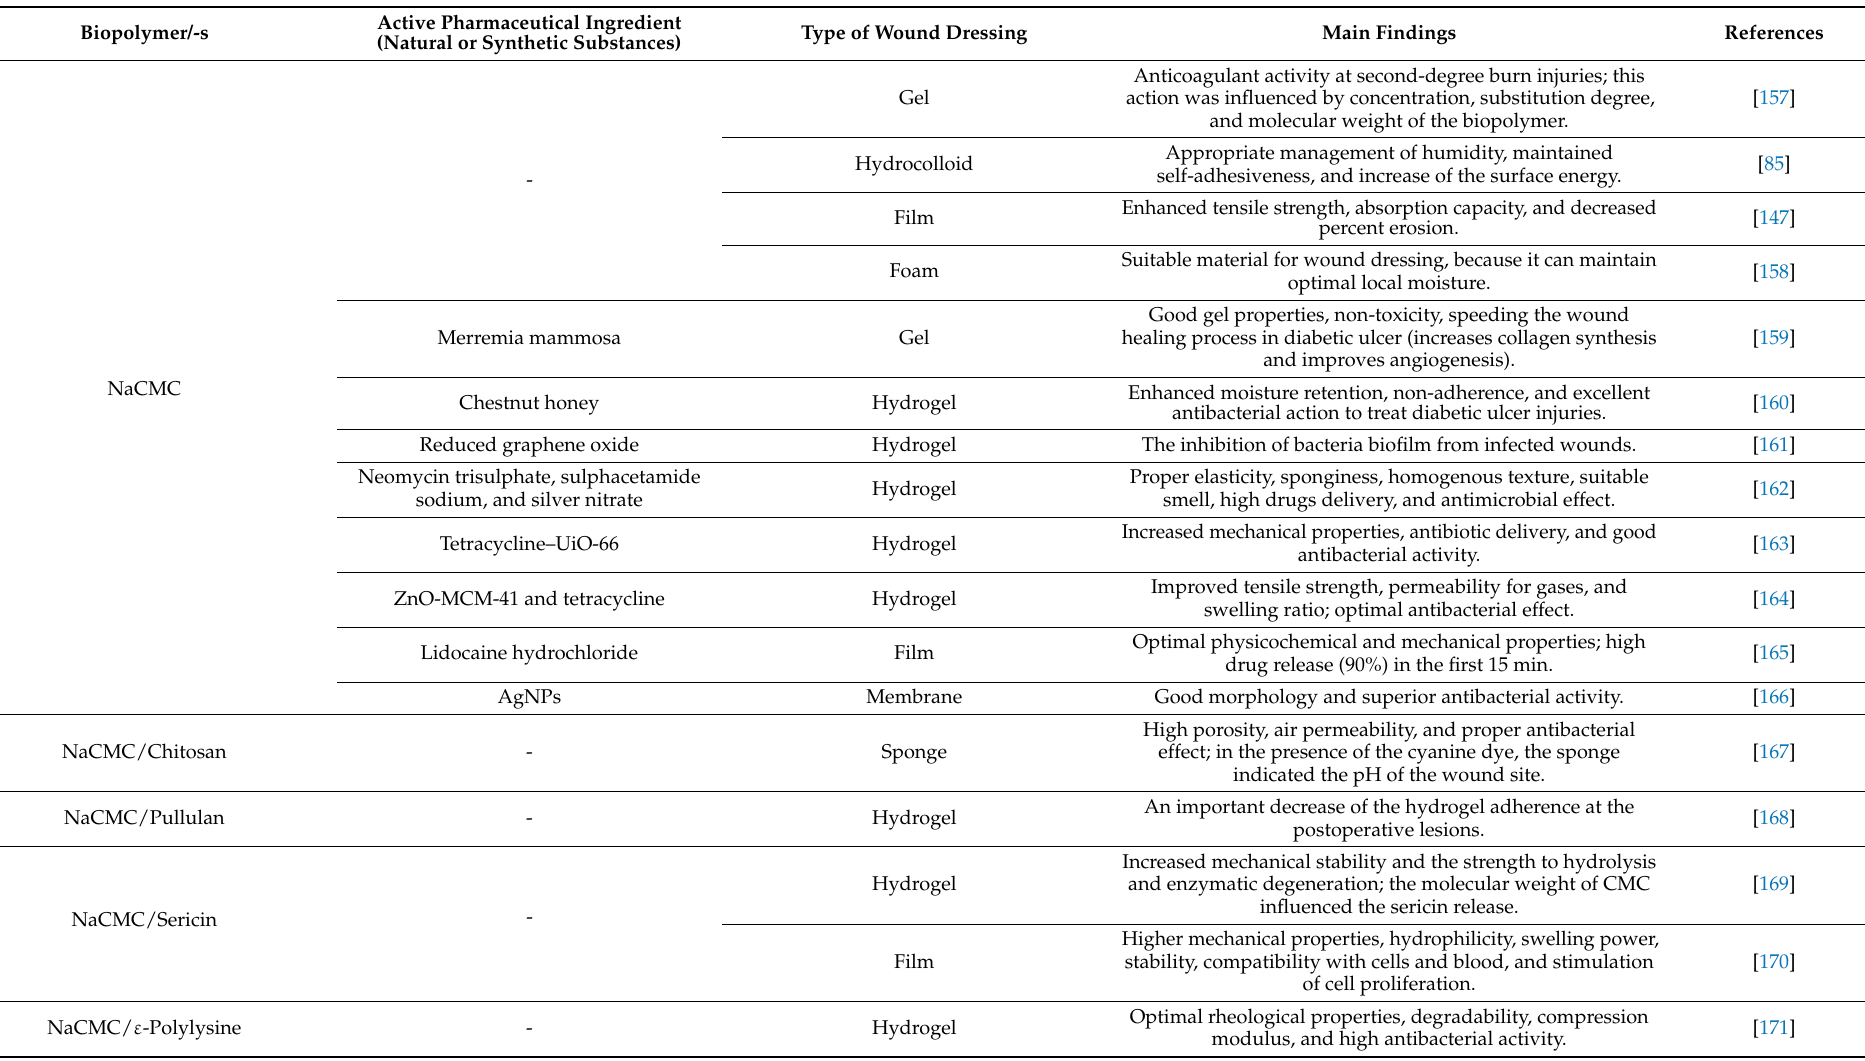
Table 3. Recent studies on the use of sodium carboxymethylcellulose as a wound